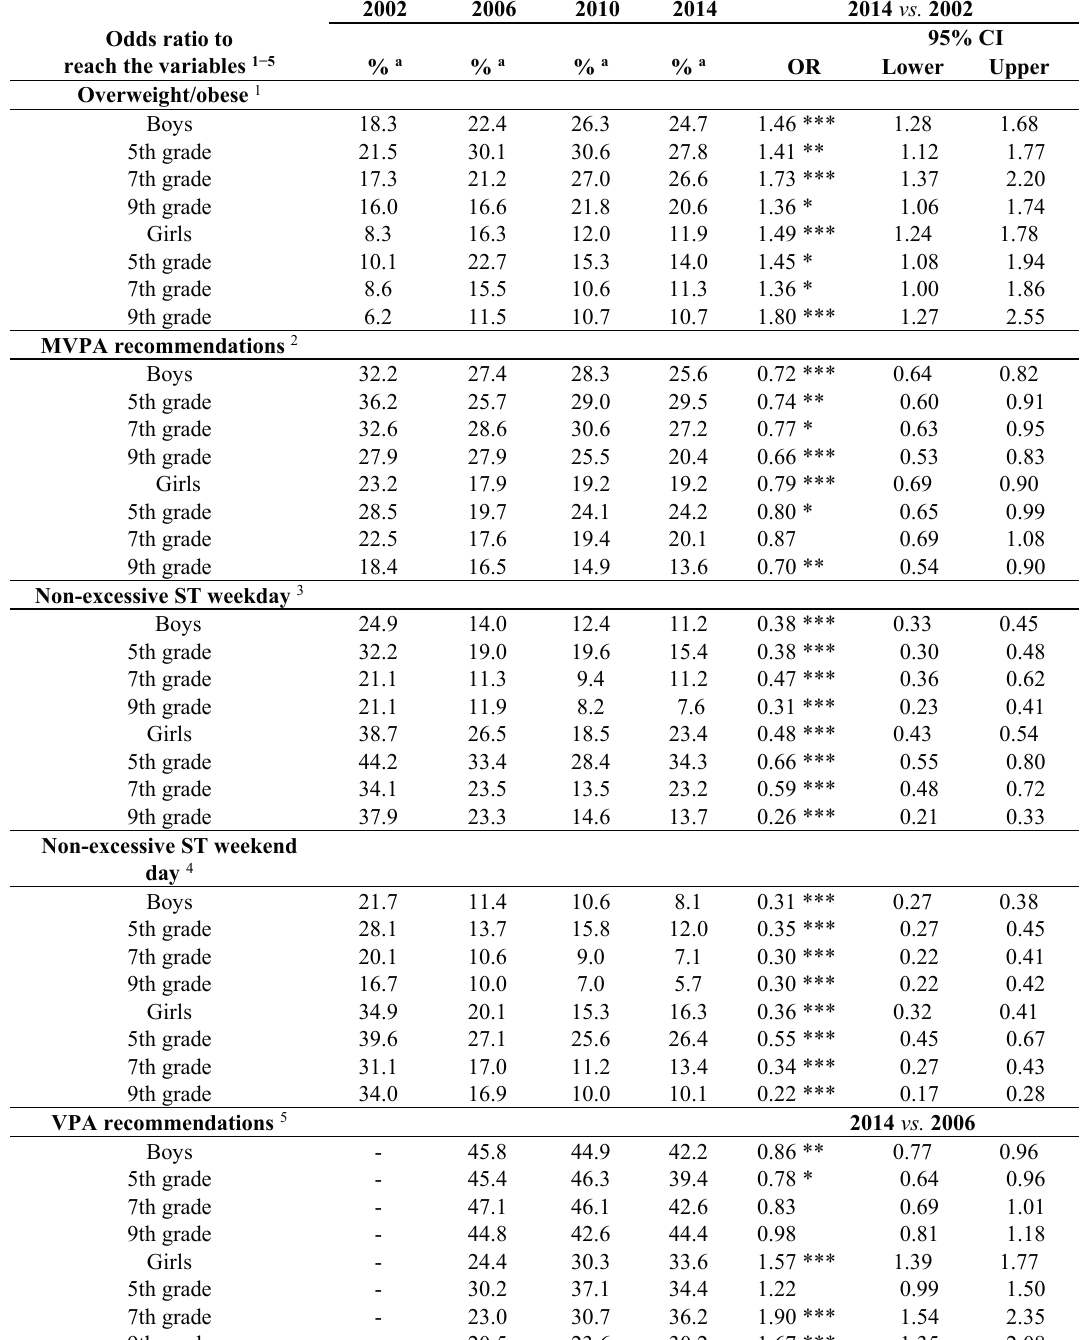
Table 2. Trends in prevalence of overweight/obesity, PA and ST recommendations in Czech adolescents between